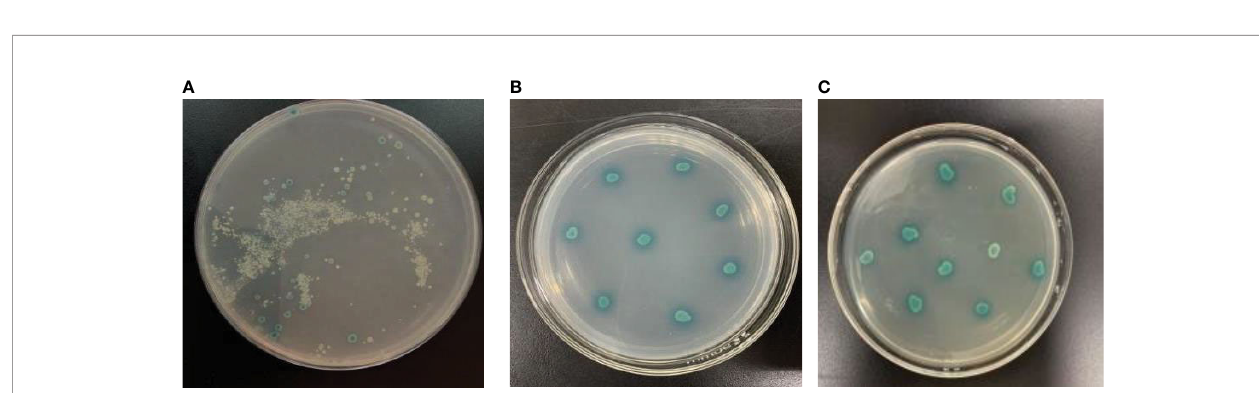
FIGURE 11 | The toxicity assays of DpAP2 protein in yeast cells. (A) PGBKT7-AP2N3. (B) pGBKT7-AP2N2. (C) PGBKT7. Yeast strains containing plasmids pGBKT7-AP2N3 and pGBKT7 could grow without signi fi cant differences in the colony size and number, which suggested that plasmid pGBKT7-AP2N3 had no effect on yeast growth and no toxicity to yeast.